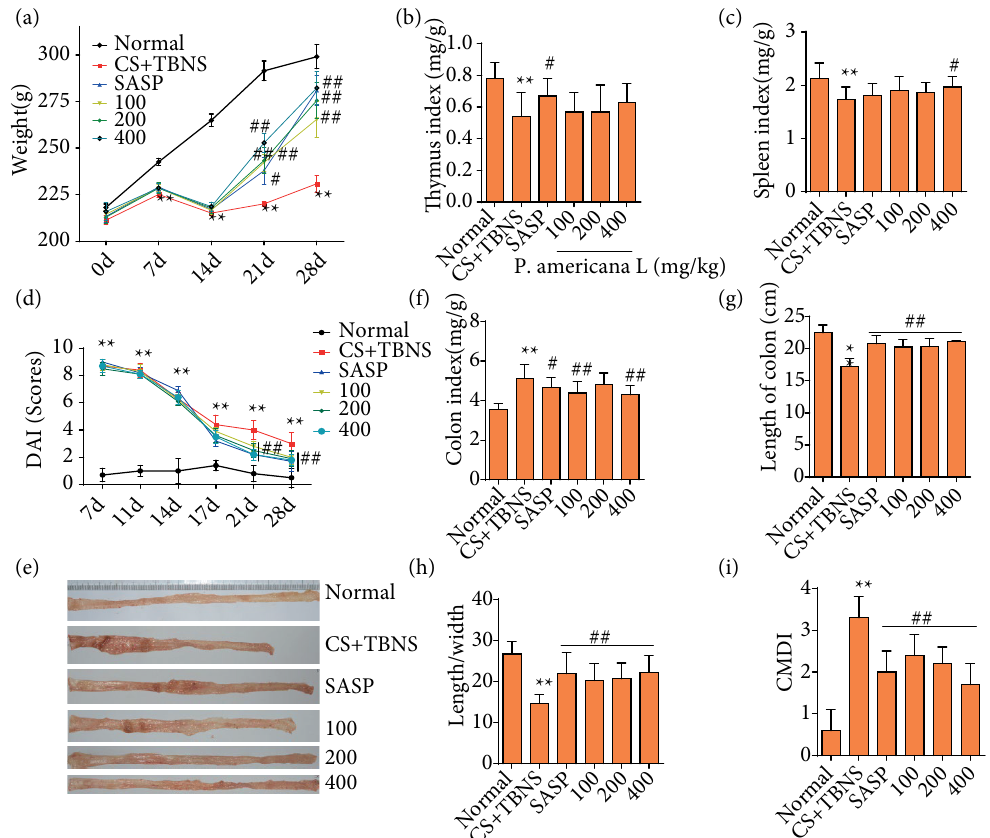
* , **Statistical significance between normal control versus other groups at p < 0.05 and p < 0.01 level; #,## statistical significance between model control versus other groups at p < 0.05 and p < 0.01 level. Figure 3 - Effect of Periplaneta americana L. on weight loss, colonic length, colonic mucosal injury index in ulcerative colitis model induced by a combination of chronic stress and 2,4,6-trinitrobenzenesulfonic acid (TNBS). Rats continuously received intragastric of sulfasalopyridine or P. americana L. for 14 days. At the end of the experimental period, rats were sacrificed, and colons were removed. (a) Weight loss. (b) Thymus index. (c) Spleen index. (d) Disease activity index. (e) Colonic morphology. (f) Colonic index. (g) Length of the colon. (h) Length-width ratio of the colon. (i) Colonic mucosal injury index scores of each group were determined. Data were presented as mean ± standard deviation (n = 10 per group); Periplaneta americana L. reduces release of proinflammatory cytokine, inhibits infiltration of inflammatory cell and damage of epithelial